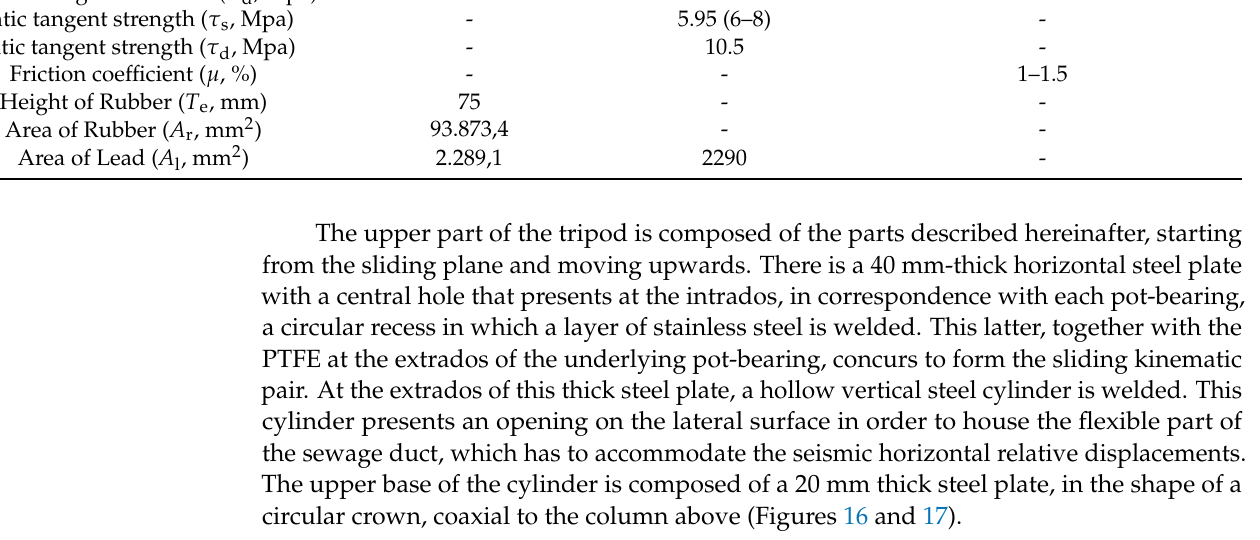
Figure 17. Technical drawings of the tripod made during their conception/design: ( a ) axonometric rendering of a whole mushroom-shaped column, ( b ) vertical cross section, and ( c ) close-up axono- metric rendering of a tripod.